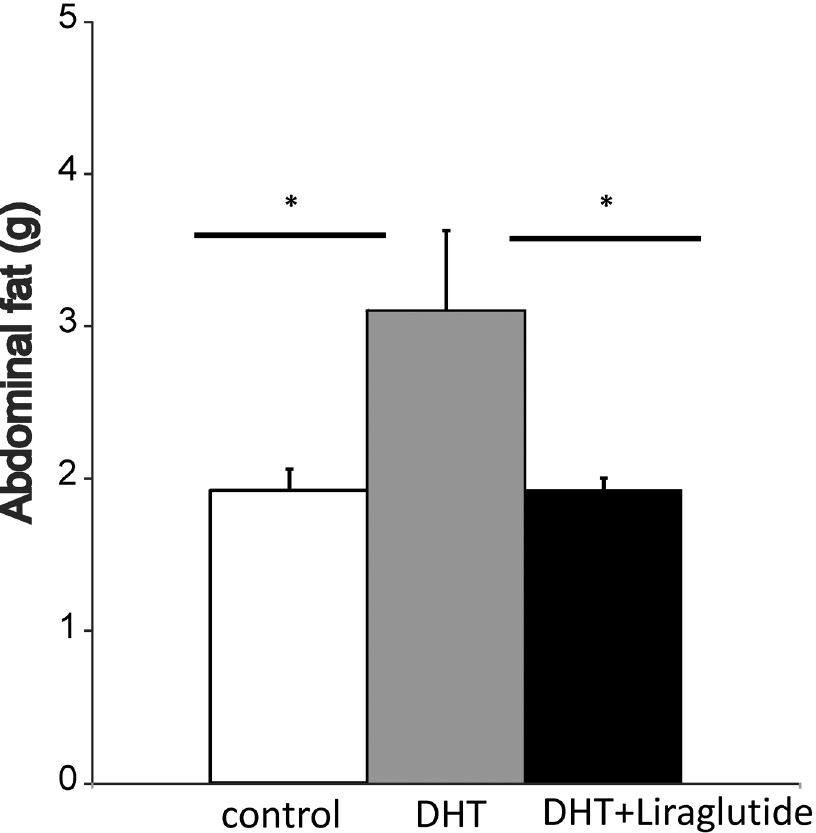
Fig 3. Effect of liraglutide on abdominal fat in DHT treated rats. (Mean ± SEM; g): Abdominal fat was collected at end of study (88 – 90 days from pellet/sham implantation) in control (n = 8), DHT (n = 11) and DHT +Liraglutide (n = 8). * denotes p < 0.05 between DHT + liraglutide and DHT and control.